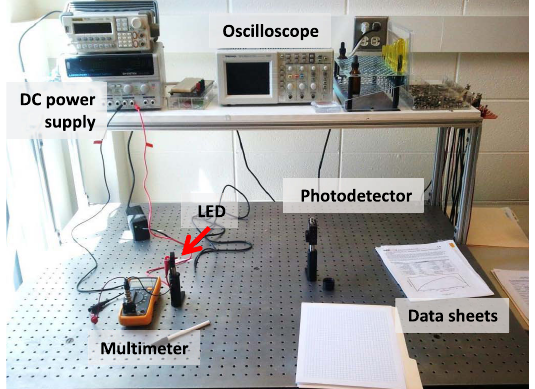
FIG. 4. Laboratory bench used for the think-aloud experimental